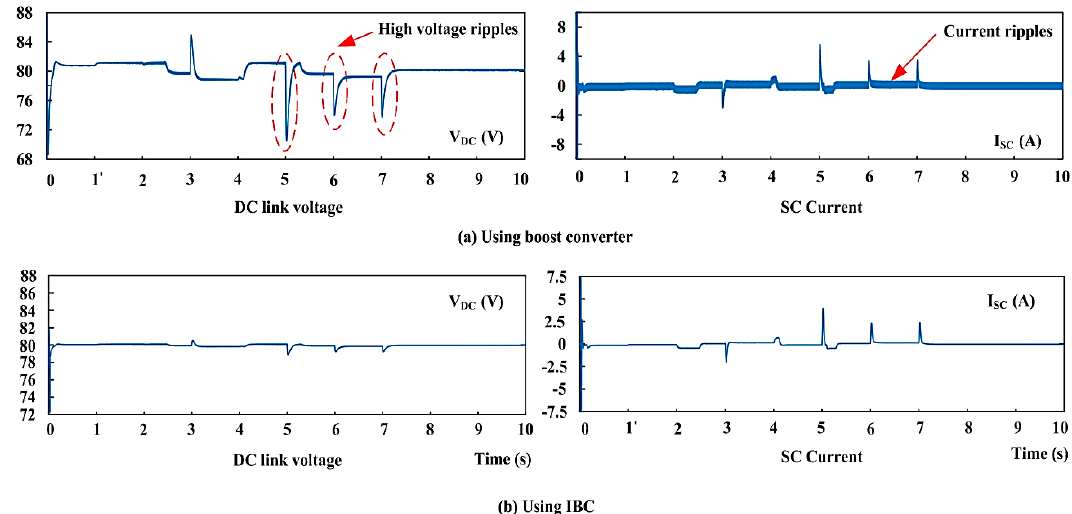
Figure 11. Simulation results.